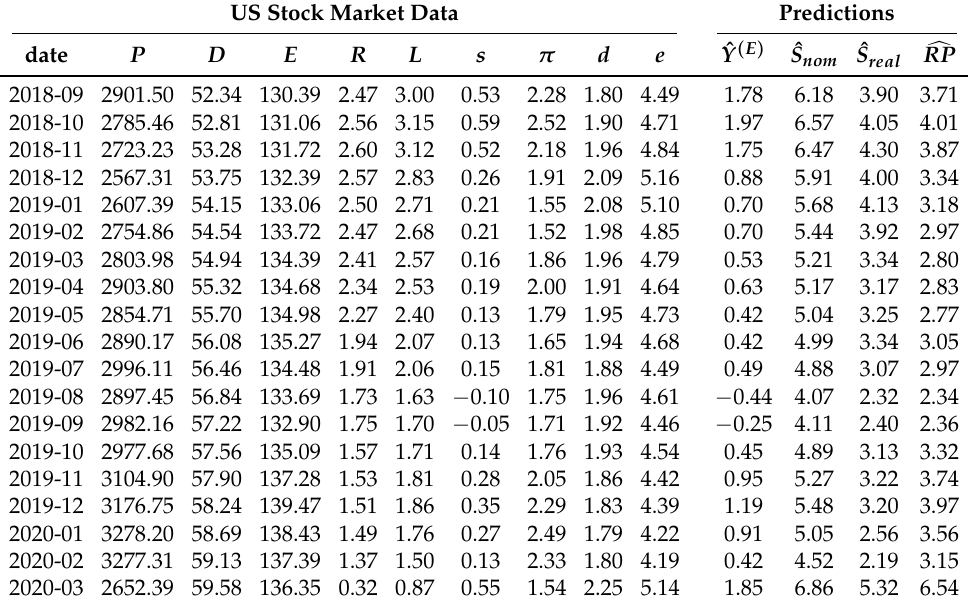
Table 6. One-year ahead real-time forecasts: predictions from the model using the single-earnings benchmark and the term spread s as covariate ( ˆ Y ( E ) = ˆ m ( s ) ) and estimated over the full sample